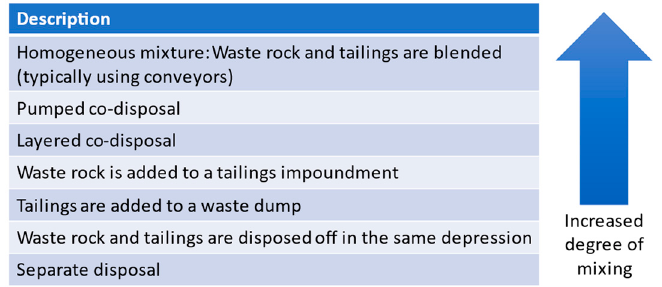
Figure 2. Forms of co-disposal, after Wickland (2006) [7].